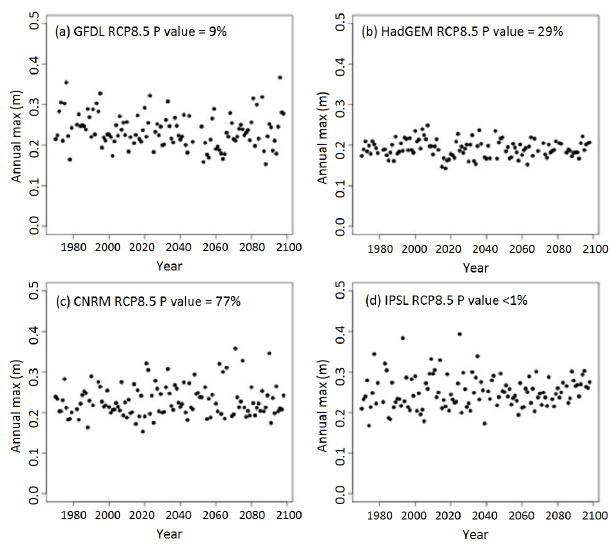
Figure 7. Annual maxima skew surge obtained from the (a) GFDL, (b) HadGEM, (c) CNRM and (d) IPSL-forced simulations. The P value indicates the statistical significance of the improvement in fit when using a non-stationary GEV model: a large P value indi- cates little improvement; a small P value indicates significant im-